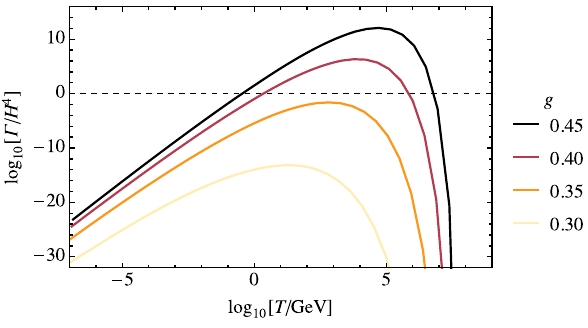
Fig. 1 The nucleation rate as a function of temperature for fixed v = 10 9 GeV and different values of